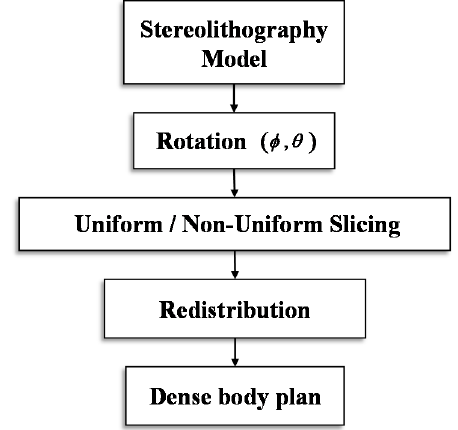
Figure 10. Stereolithographic model slicing pipeline.